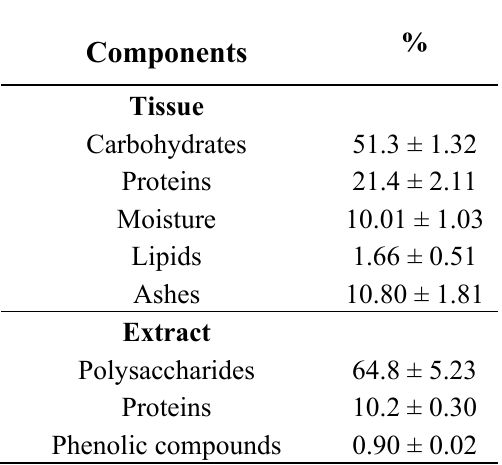
Table 1. Chemical composition of natural tissue of mushroom P. dermoporus (g/100 g dry weight) and of the polysaccharides and proteins from the extract of this mushroom.